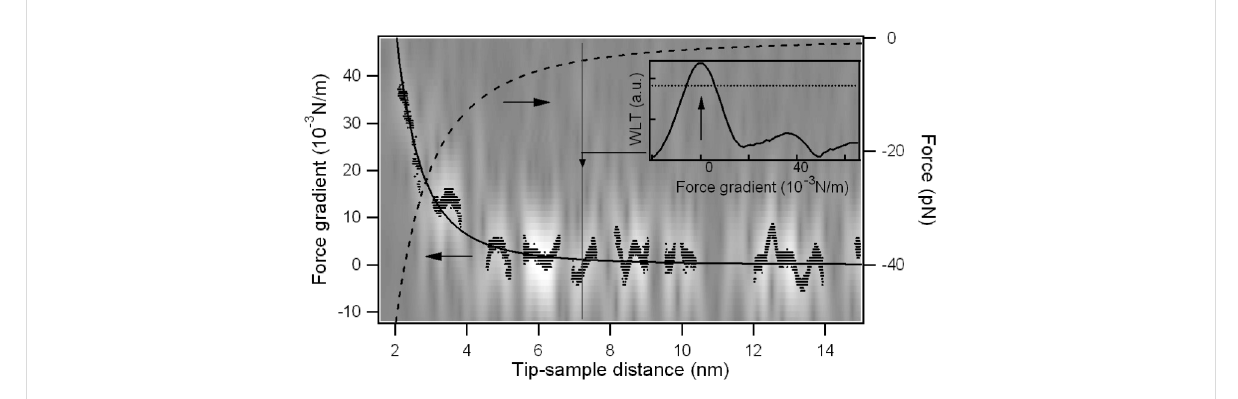
Figure 8: Force gradient versus tip-sample distance for the first flexural mode near the jump-to-contact. The wavelet ridges provide the instanta- neous frequencies within the limits of the scalogram resolution. The wavelet ridges are the local maxima of the normalized scalogram above a speci- fied threshold, as schematically shown in the inset. The threshold is represented by a horizontal line and the maximum point is indicated by an arrow for a vertical cut of the data at constant tip-sample distance. The CWT of Figure 7b is represented in gray scale on the background together with its ridges (black points). The continuous black line is an Hamaker-like force gradient function fitted to the wavelet ridges, the dashed line the force calcu- lated by integration.